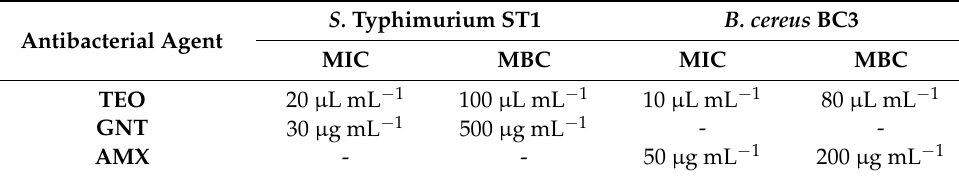
MIC, minimum inhibitory concentration; MBC, minimum bactericidal concentration; TEO, thyme essential oil; GNT, gentamicin; AMX,